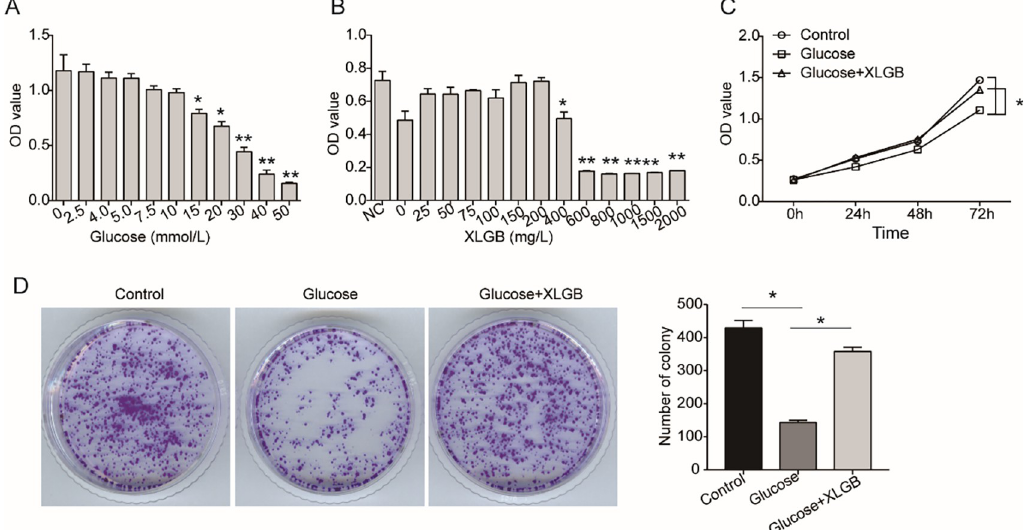
Fig 2. XLGB rescues the inhibitory effect of high glucose on the proliferation of MG63 cells. A. CCK8 assay was performed to assess the effect of different concentrations of glucose on the proliferation of MG63 cells. B. Effect of different concentrations of XLGB on the proliferation of MG63 cells exposed to high glucose (20 mM). C. Cell proliferation was examined by CCK8 assay as described in the methods at 0, 24, 48 and 72h. D. Colony formation assay was used to assess cell clonality. Control, cells treated with mannitol; Glucose, cells treated with 20 mM of glucose; Glucose +XLGB, cells treated with 20 mM of glucose plus 200 mg/L of XLGB. Data represented mean ± SD of three separate experiments. � P < 0.05, �� P < 0.01.